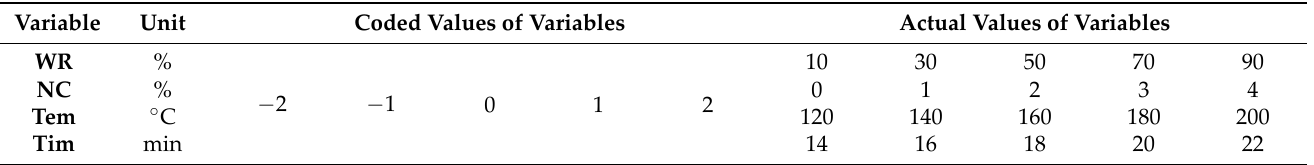
Table 1. Coded and actual values of independent